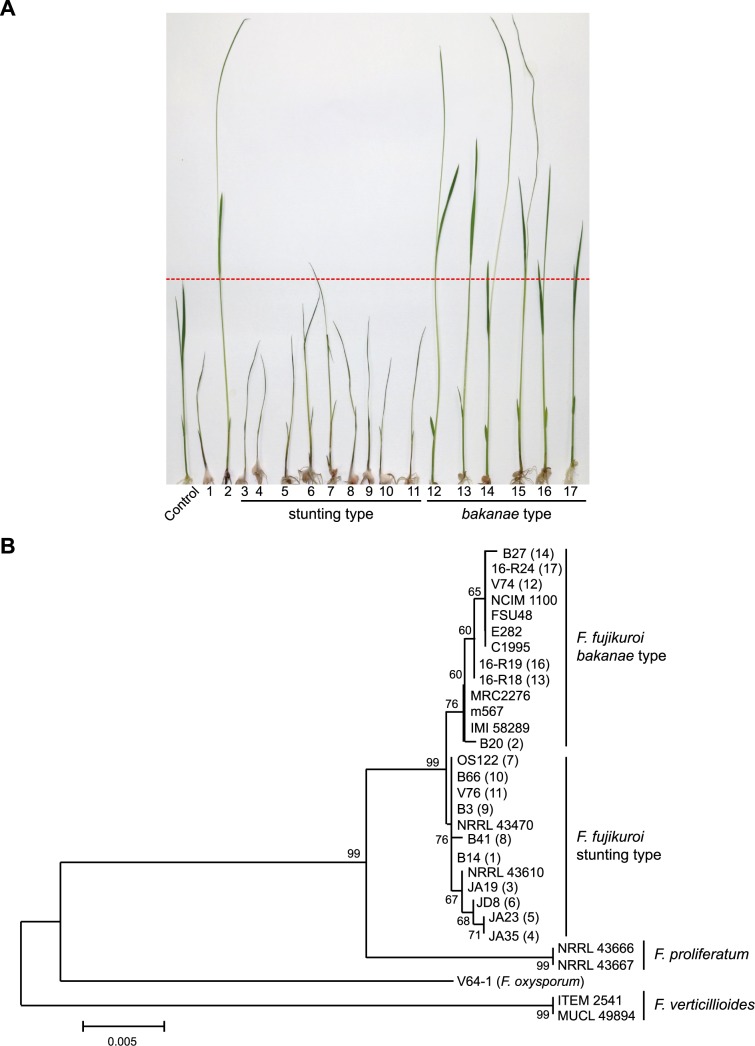
Population analysis of field isolates in Korea.(A) Rice seedlings 9 dpi of F. fujikuroi field isolates obtained from Korea. Control: no fungal inoculation, 1: B14, 2: B20, 3: JA19, 4: JA35, 5: JA23, 6: JD8, 7: OS122, 8: B41, 9: B3, 10: B66, 11: V76, 12: V74, 13: 16-R18, 14: B27, 15: B17, 16: R19, 17: 16-R24. Pathogenicity test with 15 additional isolates revealed a clear separation between the bakanae and stunting pathotype. (B) A phylogenetic tree constructed by the NJ method using the nucleotide sequences of combined TEF1 and RPB2 from the two pathotypes of field isolates, determined by pathogenicity test (A), and from the worldwide isolates used in this study. The phylogenetic tree supports the separation of the two pathotypes into two different phylogenetic subclades.